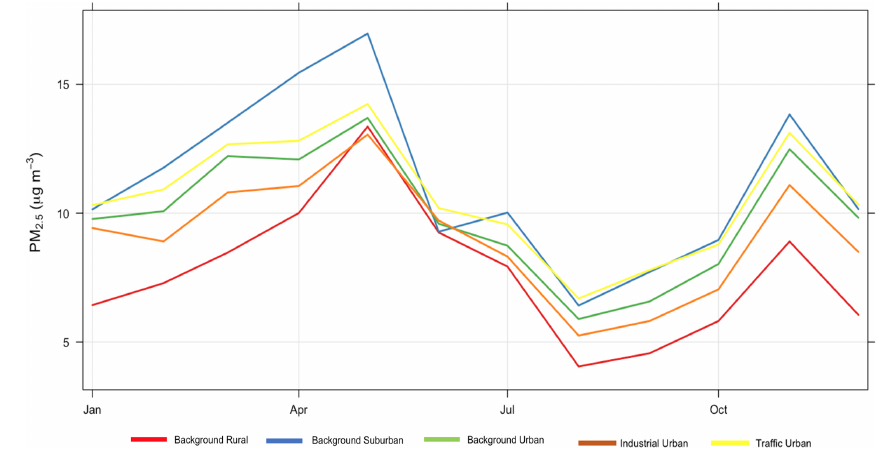
Figure 8. Monthly average concentrations of observed PM 2 . 5 for each environmental type for the year 2018.